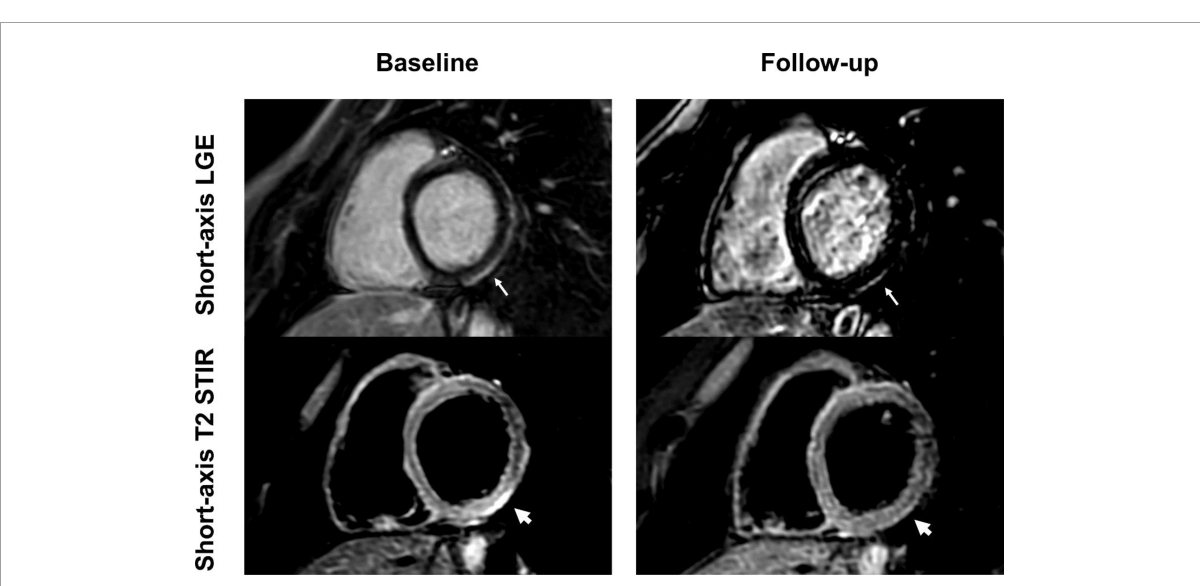
FIGURE6 Short-axis late gadolinium enhancement (LGE) and short-axis T2 short tau inversion recovery (STIR) views of a 24-year-old, previously healthy male after receiving the second dose of the Pfizer/BioNTech vaccine. LGE at the basal inferolateral wall (thin arrows) shows a marked decrease at 6-month follow-up, with only minimal remaining findings. T2 STIR imaging shows focal myocardial edema corresponding to the location of the LGE (thick arrows) with complete resolution at follow-up. The patient reported complete resolution of previous clinical symptoms but complained of new onset exertional